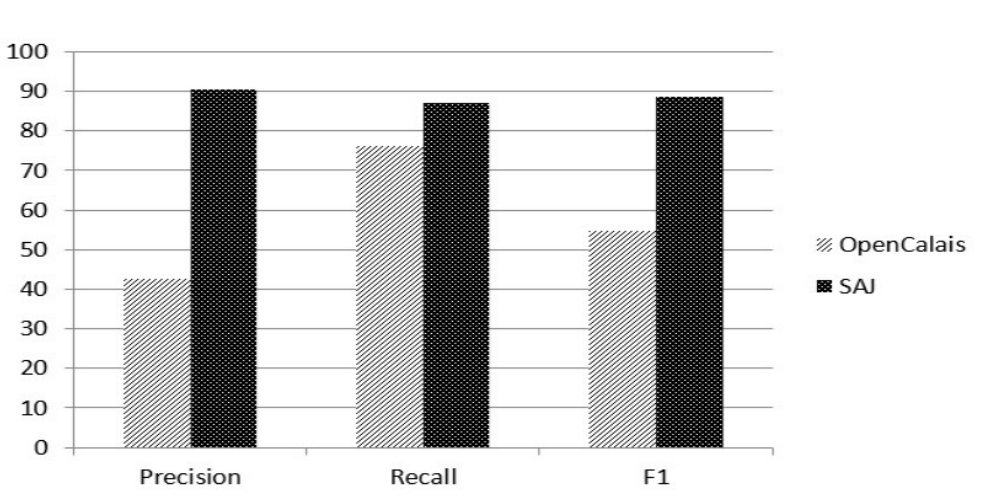
Figure 11. Comparative analysis among SAJ and OpenCalais for